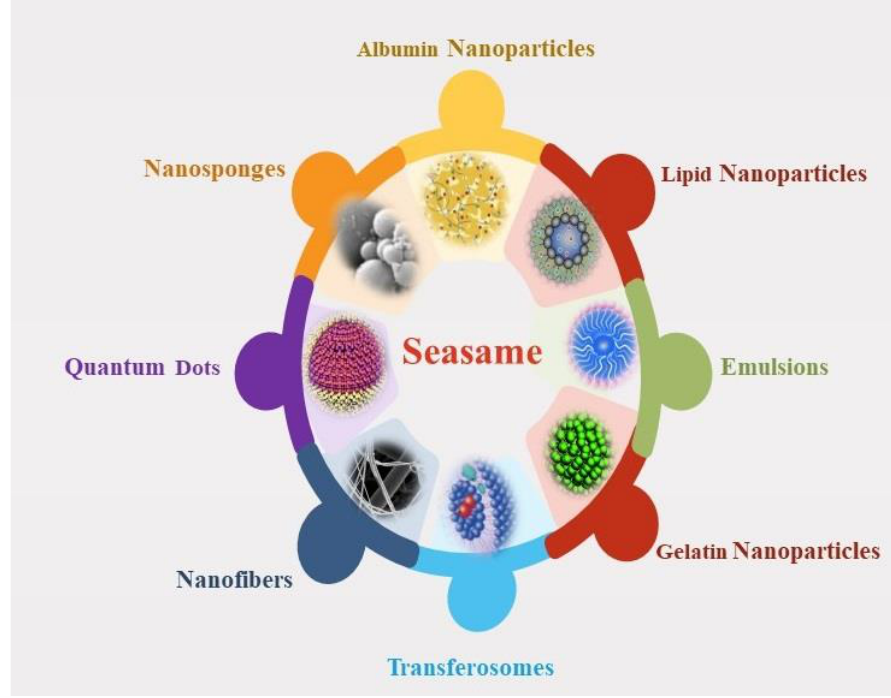
Figure 4. Nanoformulations of Sesamol.